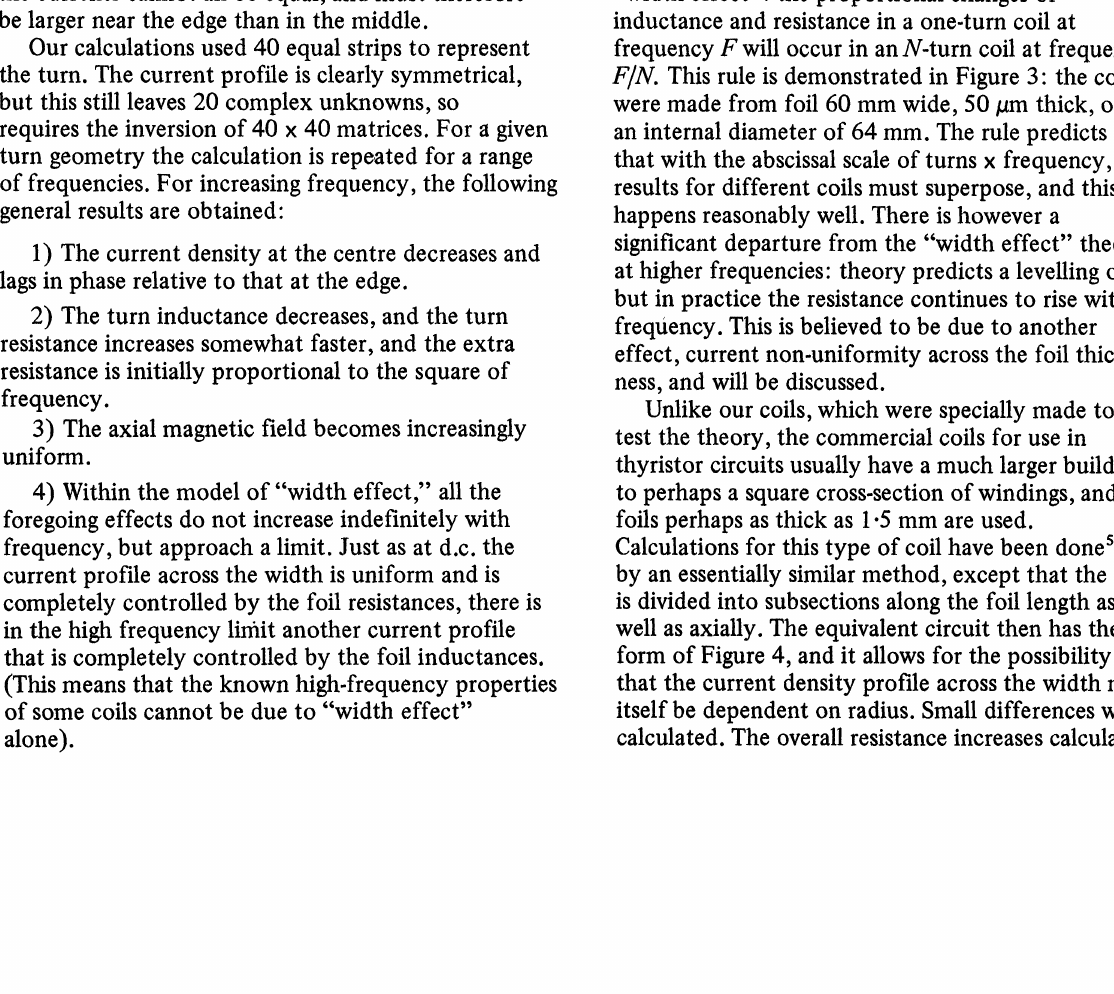
One-turn foil coil with torus-bars to maintain equipotential connections.